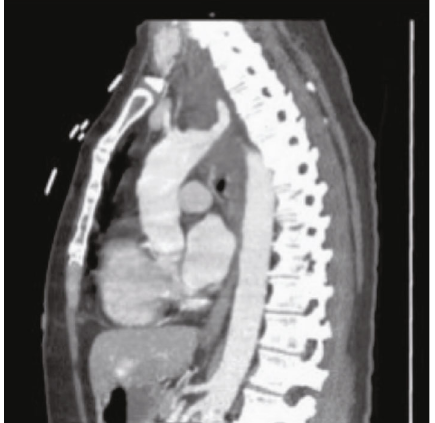
Figure 2: Aberrant right subclavian artery coursing posterior to the trachea and esophagus